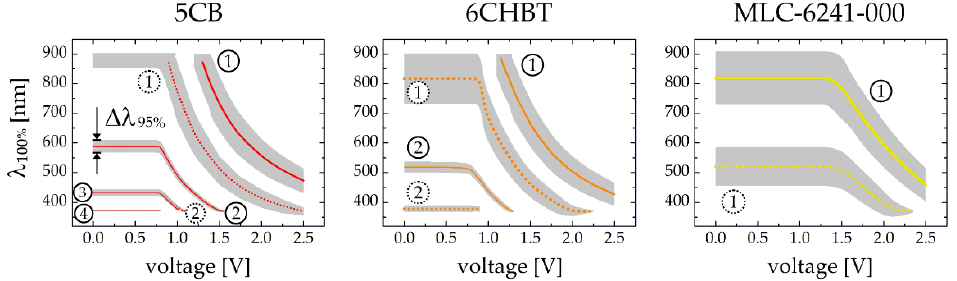
Figure 6. The wavelengths corresponding to the maxima of the first order diffraction efficiency (DE 1 ) as the functions of applied voltage. The lines represent the spectral positions of the maxima ( λ 100% ) while the gray shadows behind them illustrates the spectral ranges for which DE 1 ≥ 95% ( ∆ λ 95% ). Results are numerically calculated for selected liquid crystalline materials (5CB, 6CHBT, E7) and for two different thicknesses of LC cell ( d = 5 µm, Λ = 10 µm—solid lines; d = 3 µm, Λ = 7 µm—dotted lines). Numbering of successive maxima, defined as the multiple of the half-wave condition for d Δ n eff , is indicated in each case.